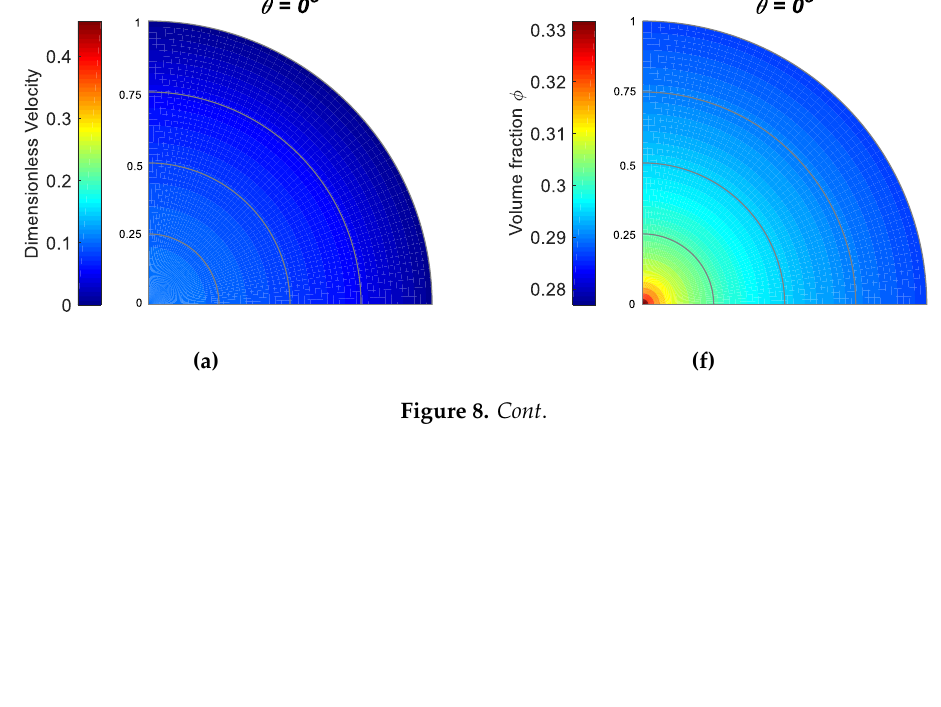
K c = 0.05, 𝜙 𝑚 = 0.65, 𝑚 = 1. = 0.05, φ m = 0.65, 𝐾 𝜇 K µ